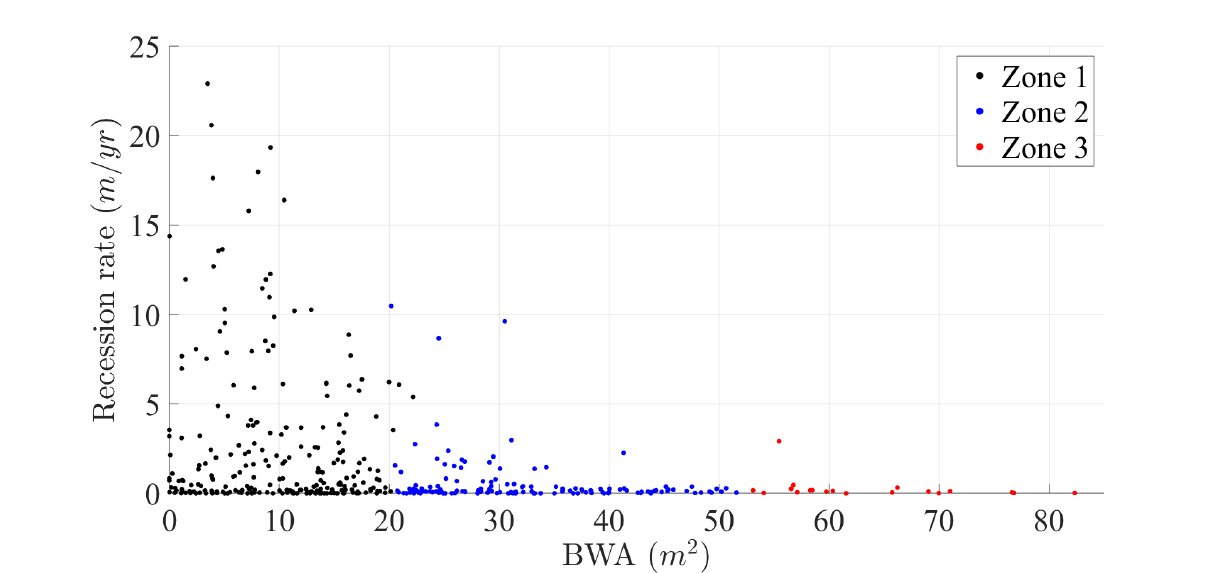
Figure A6. Annual scale relationship between BWA and cliff top recession rates for North Norfolk and Suffolk unprotected cliffs from 1993–2018. The colours indicate the three zones obtained using the hierarchical clustering method, where the results of profile SWE7 since the year 2008 have not been taken into account, as this location is a special case related with the Benacre Ness